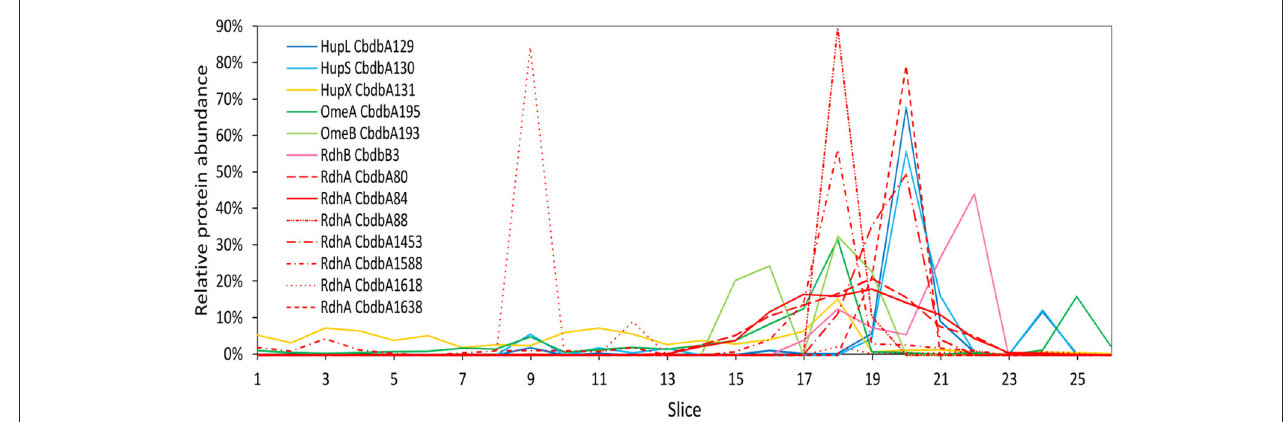
FIGURE 2 | Relative abundance of proteins associated with the OHR complex across the length of a blue native gel cut into 26 slices after whole-cell DDM solubilization (protein extraction mode 1). The color code is the same as shown in Figure 1 . Different RdhA proteins are shown with different line types.